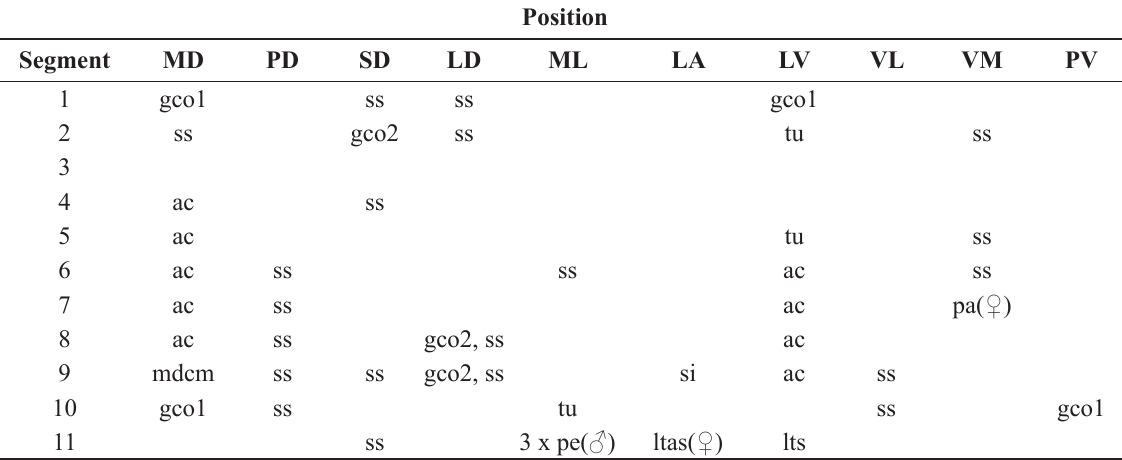
Table 15. Summary of nature and location of sensory spots, glandular cell outlets, tubes and spines arranged by series in Echinoderes yamasakii sp. nov. Abbreviations: LA = lateral accessory; LD = laterodorsal; LV = lateroventral; MD = middorsal; ML = midlateral; PD = paradorsal; PV = paraventral; SD = subdorsal; VL = ventrolateral; VM = ventromedial; ac = acicular spine; gco1/2 = glandular cell outlet type 1/2; ltas = lateral terminal accessory spine; lts = lateral terminal spine; mdcm, middorsal cuticular marking; pa, papilla; pe = penile spines; si = sieve plate; ss = sensory spot; tu = tube; ( ♀) , female and ( ♂ ), male conditions of sexually dimorphic